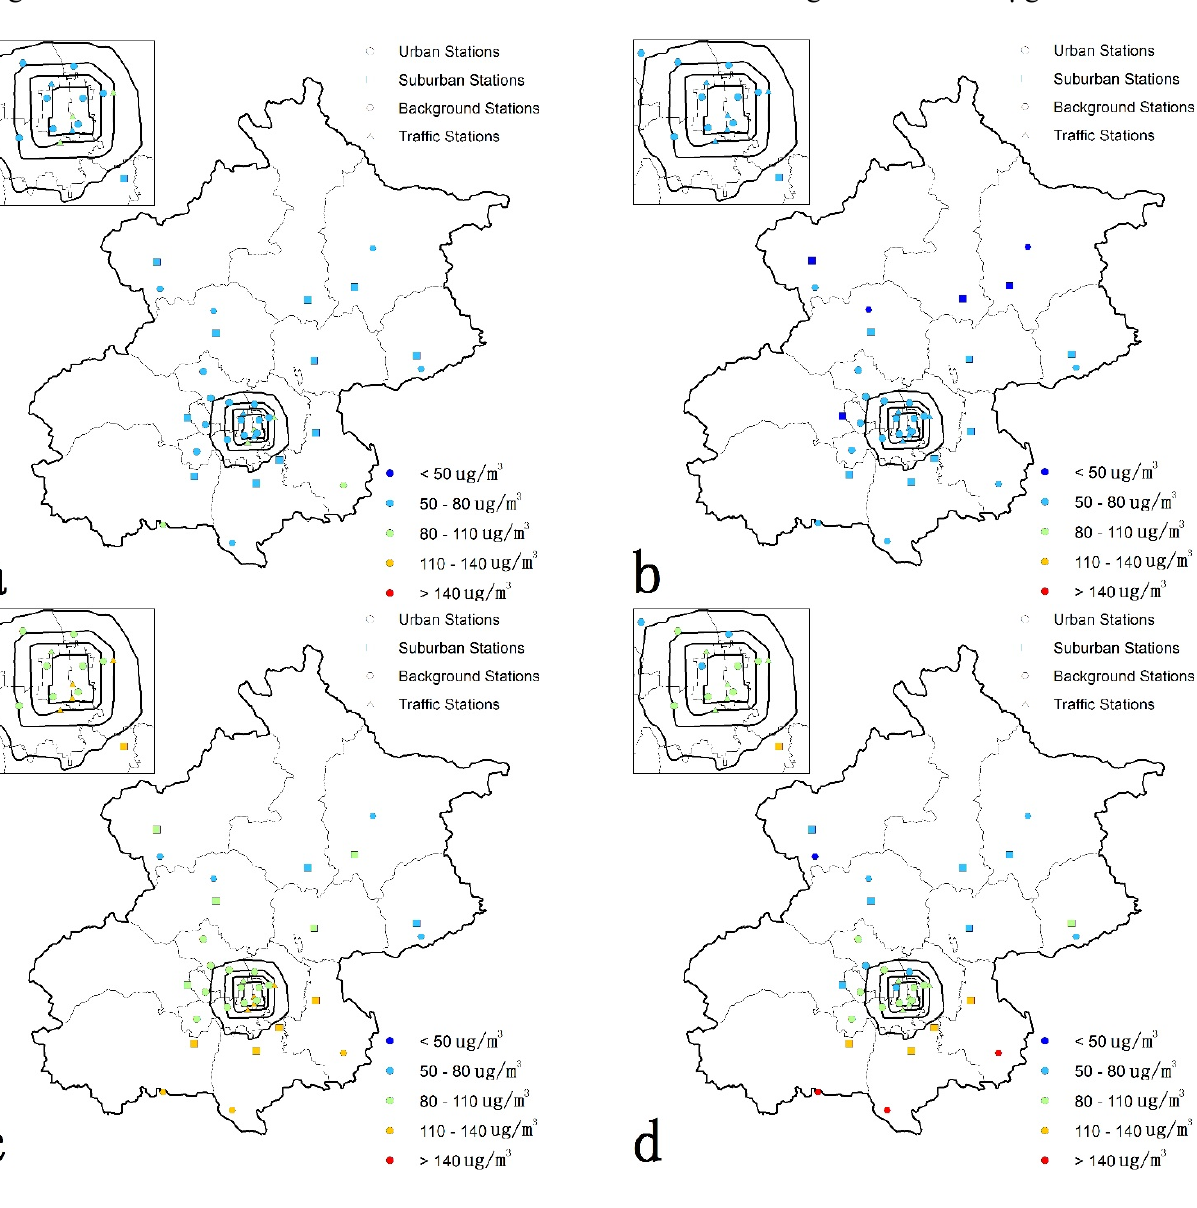
Figure 6. Seasonal variations of PM 2.5 concentrations for the 35 air quality monitoring stations (( a ) spring; ( b ) summer; ( c ) autumn; ( d )